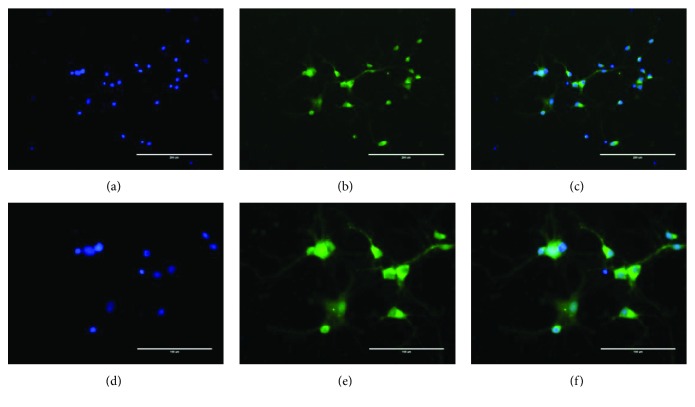
Neurons from the rat spinal cord: (a) DAPI immunofluorescent staining (20x), (b) NSE immunofluorescent staining (20x), (c) NSE-GFP-DAPI merge (20x), (d) DAPI immunofluorescent staining (40x), (e) NSE immunofluorescent staining (40x), and (f) NSE-GFP-DAPI merge (40x). Immunofluorescent staining was performed to identify neurons. NSE/DAPI > 90%. Each experiment was repeated three times.